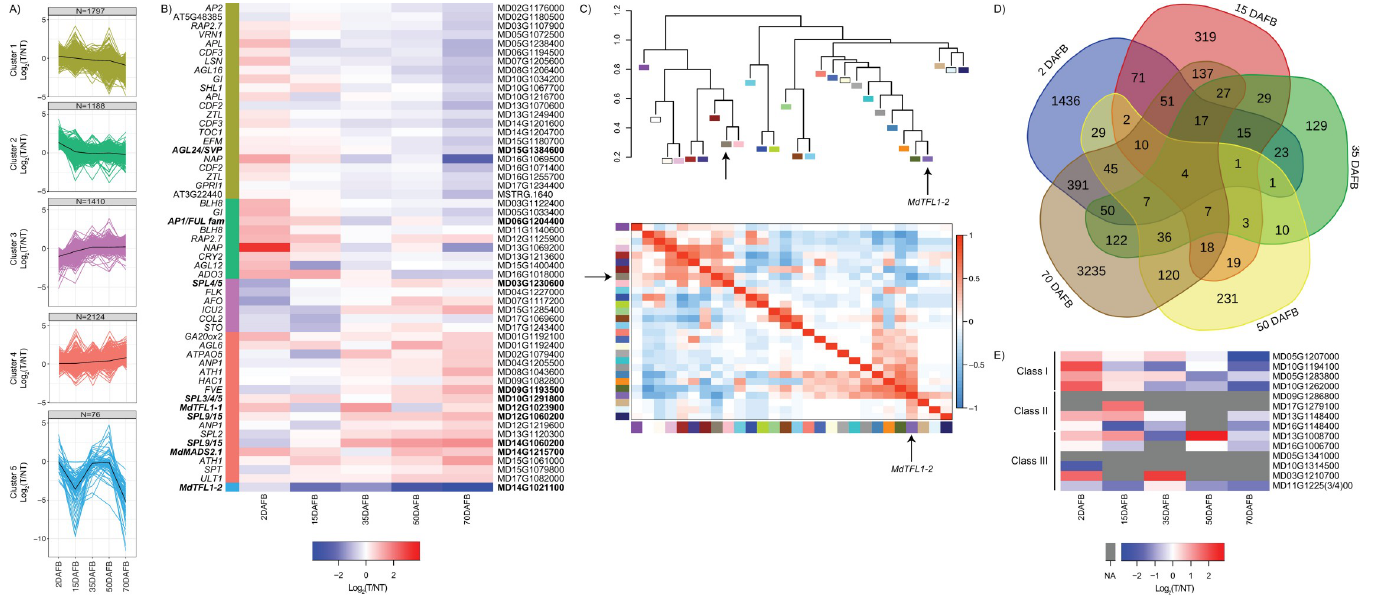
Fig 5. Expression characteristics of genes that are differentially expressed between thinned and non-thinned apices. A) Expression plots for flowering gene homologs that exhibited significant differences in expression between thinned (T) and non-thinned (NT) apices. Expression profiles were grouped into similar patterns using K - means clustering ( k = 5). For each cluster, the average expression pattern is represented by a black line. Expression levels (FPKM) were log 10 transformed. N = number of flowering genes assigned to the respective cluster. B) Heatmap of the fold difference in expression between thinned (T) and non-thinned (NT) samples for flowering gene homologs at each sample date. Homolog nomenclature is represented by gene symbols or Arabidopsis gene IDs on the left of the heatmap. On the right of the heatmap are the GDDH13 reference loci. Gene symbols and IDs shown in bold represent the subset of intensively studied flowering gene homologs listed in Table 2. C) Identification of genes co-expressed with MdTFL1-2 . The dendrogram at top depicts the relationship among the modules. Colored rectangles represent all co-expression modules identified in this study. The module containing MdTFL1-2 is shown in purple and is indicated. The module with the most significant negative correlation with the MdTFL1-2 module is shown in brown and is indicated with a non-labeled arrow. The heat map at bottom represents the correlation values between modules (dark blue, strongly negatively correlated; dark red, strongly positively correlated). D) Venn diagram depicting the numbers of differentially expressed genes at each sample date. E) Heatmap of the fold difference in expression between thinned (T) and non-thinned (NT) samples for GA2ox homologs at each sample date. The GDDH13 reference locus id is shown at the right. The assigned class of each homolog is shown at the left. Cells for which no expression value was available are shown in gray (NA).